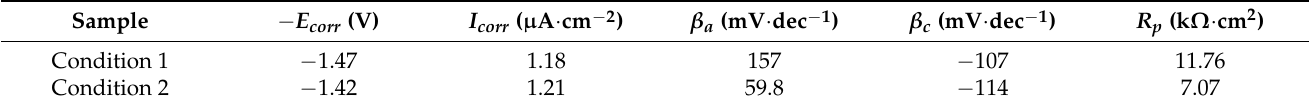
Figure 4. Surface morphologies and EDS spectra of the coatings in ( a , b ) condition 1 and ( c , d ) condition 2. Table 4. Electrochemical parameters of the coatings in conditions 1 and 2.